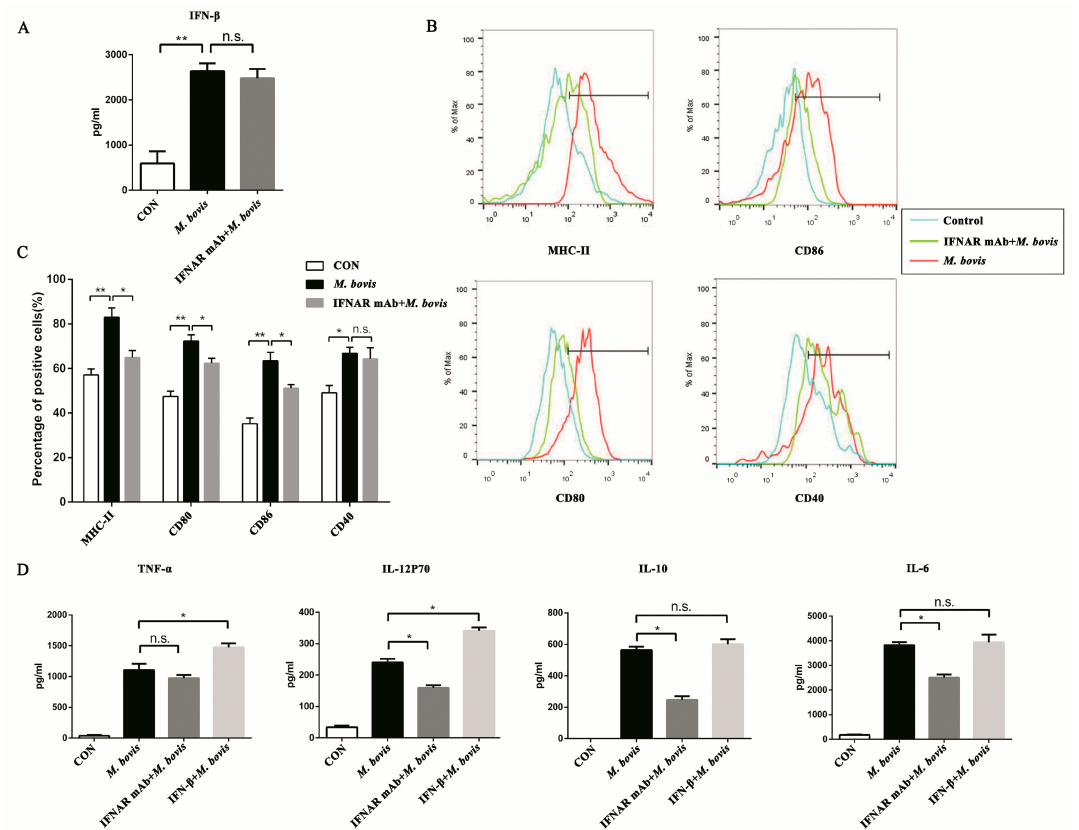
Figure 3. Type I interferon (IFN) and its receptor (IFNAR) contribute to the cGAS pathway in BMDCs. ( A ) The expression of IFN- β was assayed after anti-mouse IFNAR monoclonal antibody (mAb; 10 ng/mL) treatment. ( B ) The cell surface markers of CD40, CD80, CD86, and MHC class II were analyzed by flow cytometry in BMDCs transfected with siCon or sicGAS and then infected for 24 h with M. bovis (MOI 5). The CD11c marker was used to set the gate for flow cytometric analysis. The interferon receptor was treated with neutralizing anti-mouse IFNAR mAb (10 ng/mL) to block and then infected for 24 h with M. bovis (MOI 5). ( C ) The positive cell rate of surface markers in each group was calculated, and histograms were generated by FlowJo software. ( D ) Culture supernatants were harvested after 24 h; the expression of TNF- α , IL-6, IL-10, and IL-12p70 was assayed by ELISA. IFN- β + M. bovis : BMDCs were treated with exogenous IFN- β (10 ng/mL) and then infected with M. bovis [16]. All data are expressed as mean ± SD, (* p < 0.05; ** p < 0.01; n.s.: no statistical significance).